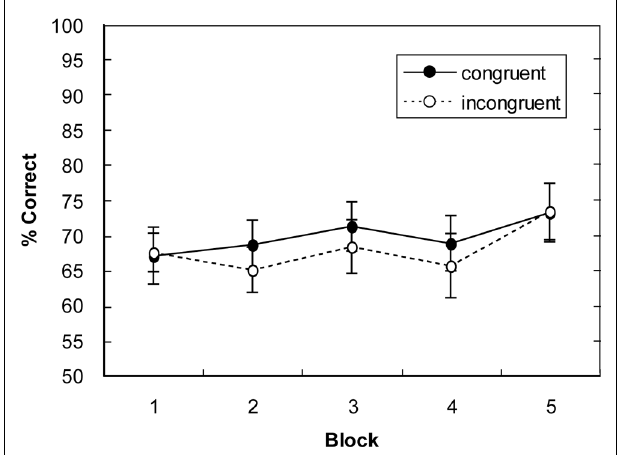
FIGURE 4 | Mean percentage of correct responses for global- congruent and -incongruent display layouts as a function of block in Experiment 2. Error bars indicate the standard error of the